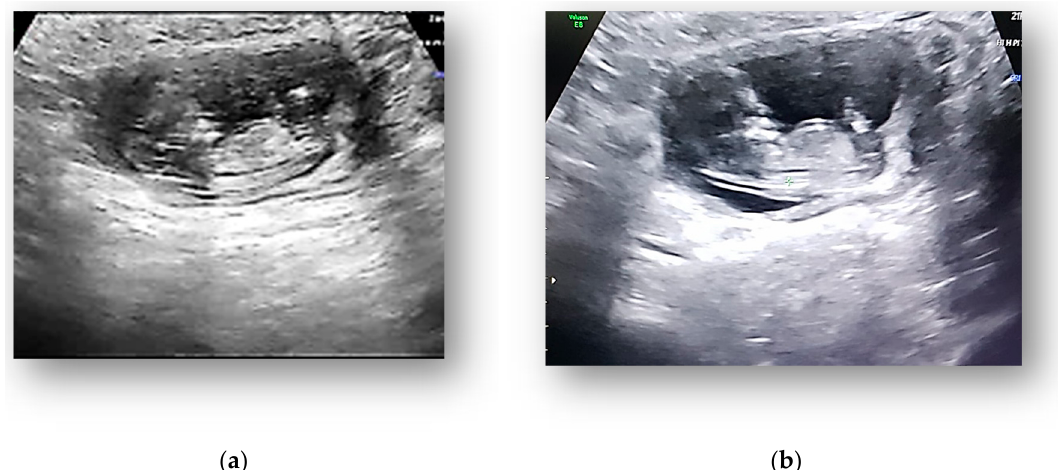
Figure 2. ( a ) Ultrasound showed in the left abdominal flank a gestational sac with a live fetus corresponding to the gestational age of 13 weeks. ( b ) Ultrasound showed gestational sac with fetus corresponding to 13 weeks.